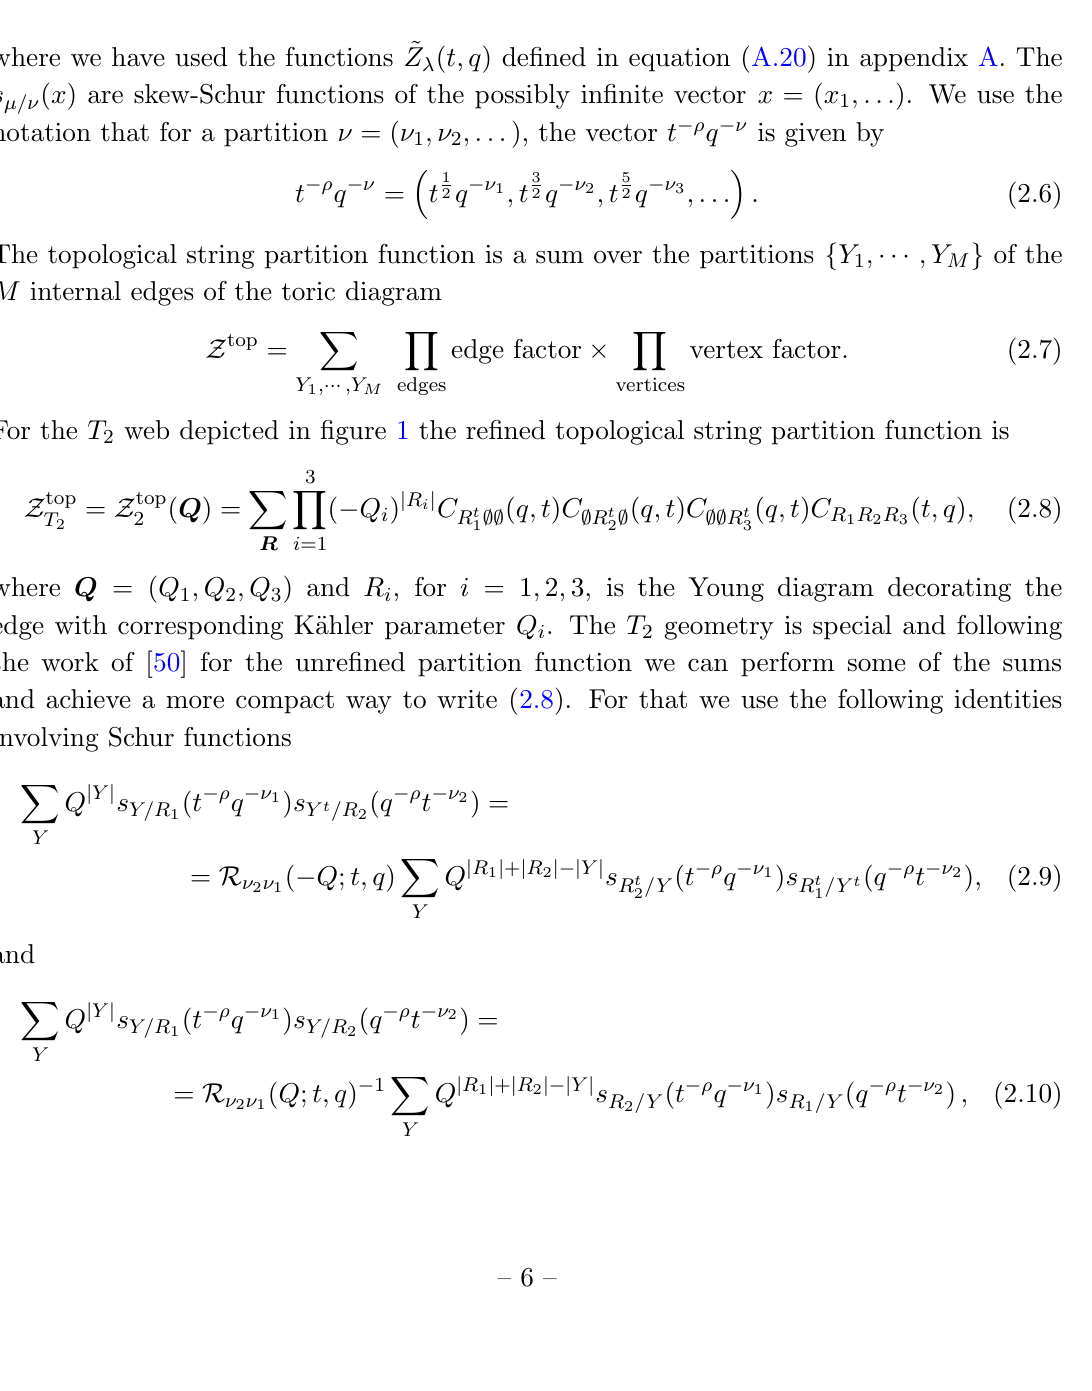
Figure 4 . The assignment of framing factors to edges of a web